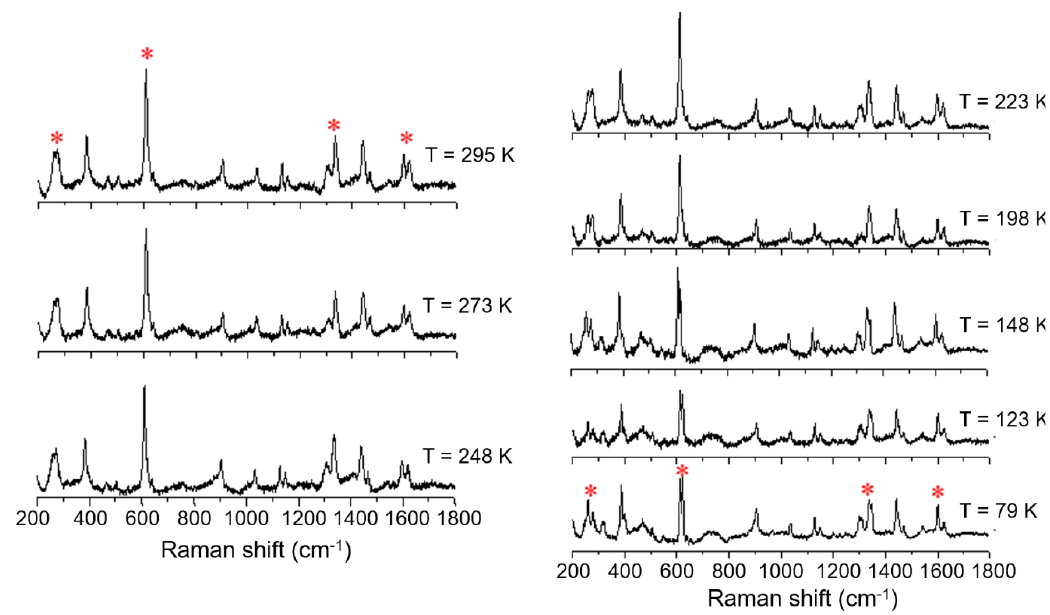
Figure 7. Variable temperature Raman spectra of [FeL 1C6 ]BF 4 , 1 , using laser excitation at 785 nm in the temperature range of 79 K to 295 K.